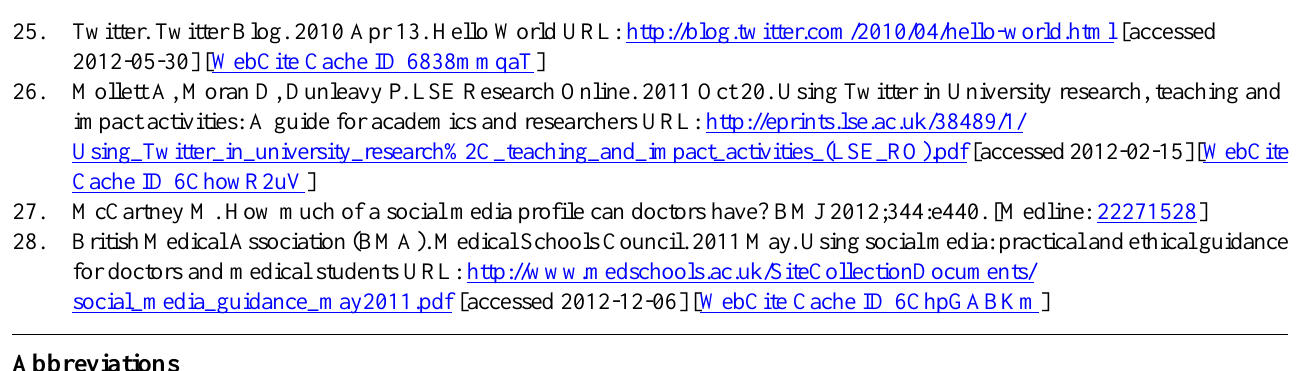
AAGBI: Association of Anaesthetists of Great Britain and Ireland SMS: Short Message